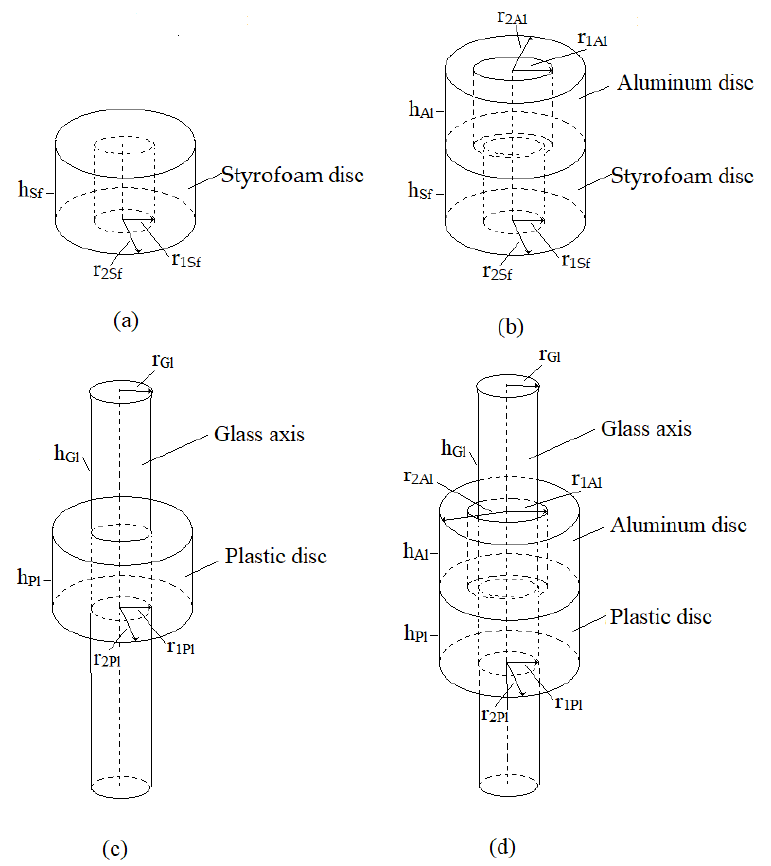
Figure 16. The schemes of the composite rotors. ( a ) Floating unloaded rotor. ( b ) Floating loaded rotor. ( c ) Submerged unloaded rotor. ( d ) Submerged loaded rotor.